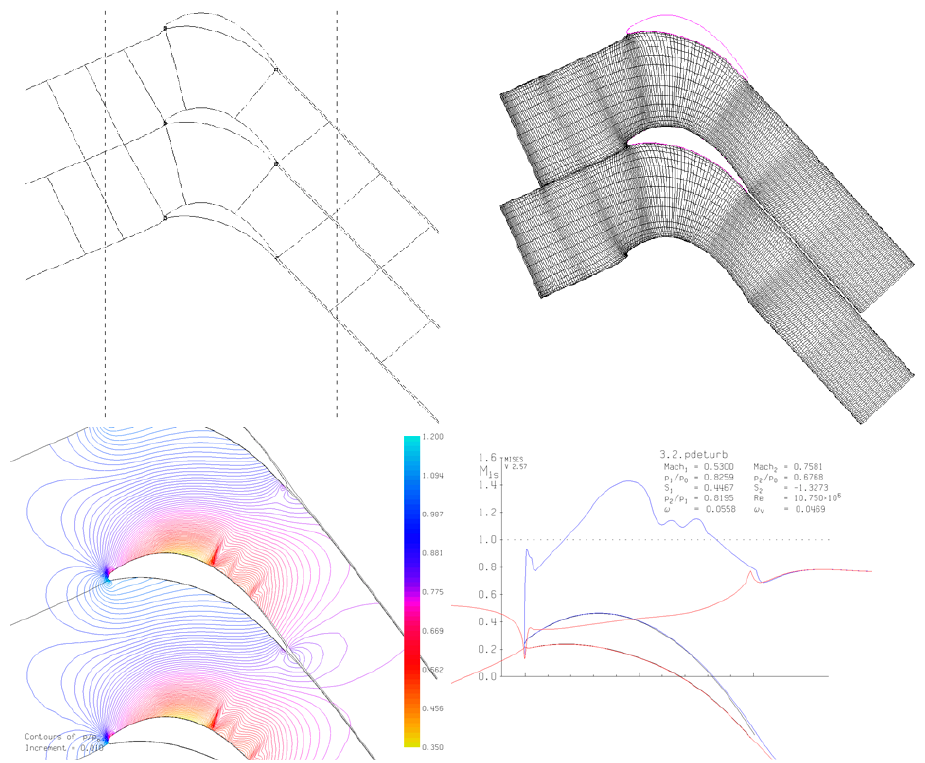
Figure 6. Quasi-3D run on a turbine blade using MISES showing surface distribution of Mach.